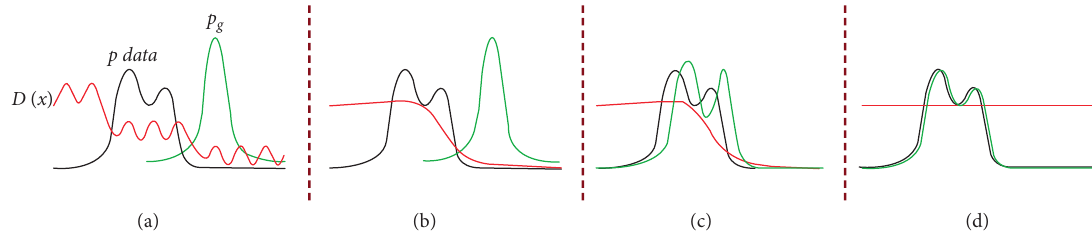
Figure 4: Illustrating a GAN-Holo learning to map uniform noise to the normal